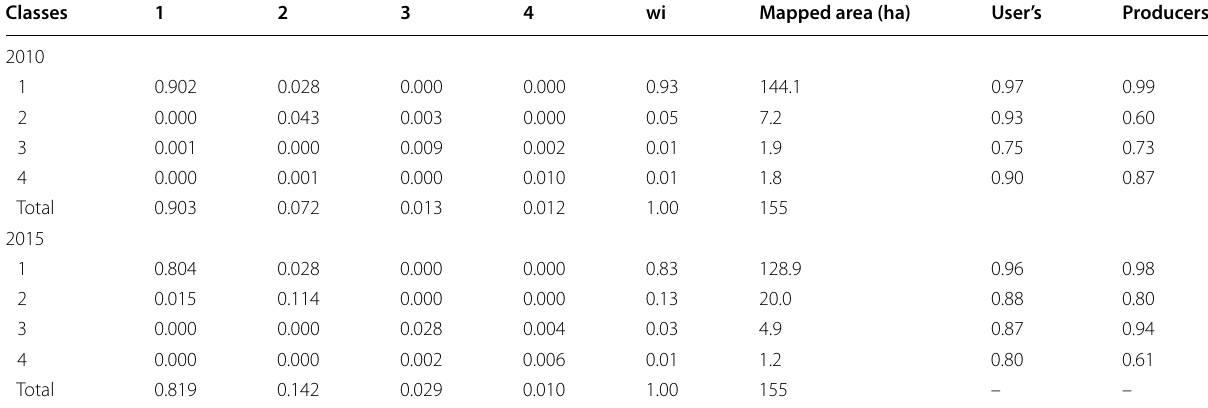
1 cropland, 2 vegetation, 3 grassland, 4 settlement. Rows and columns represent map and reference categories respectively